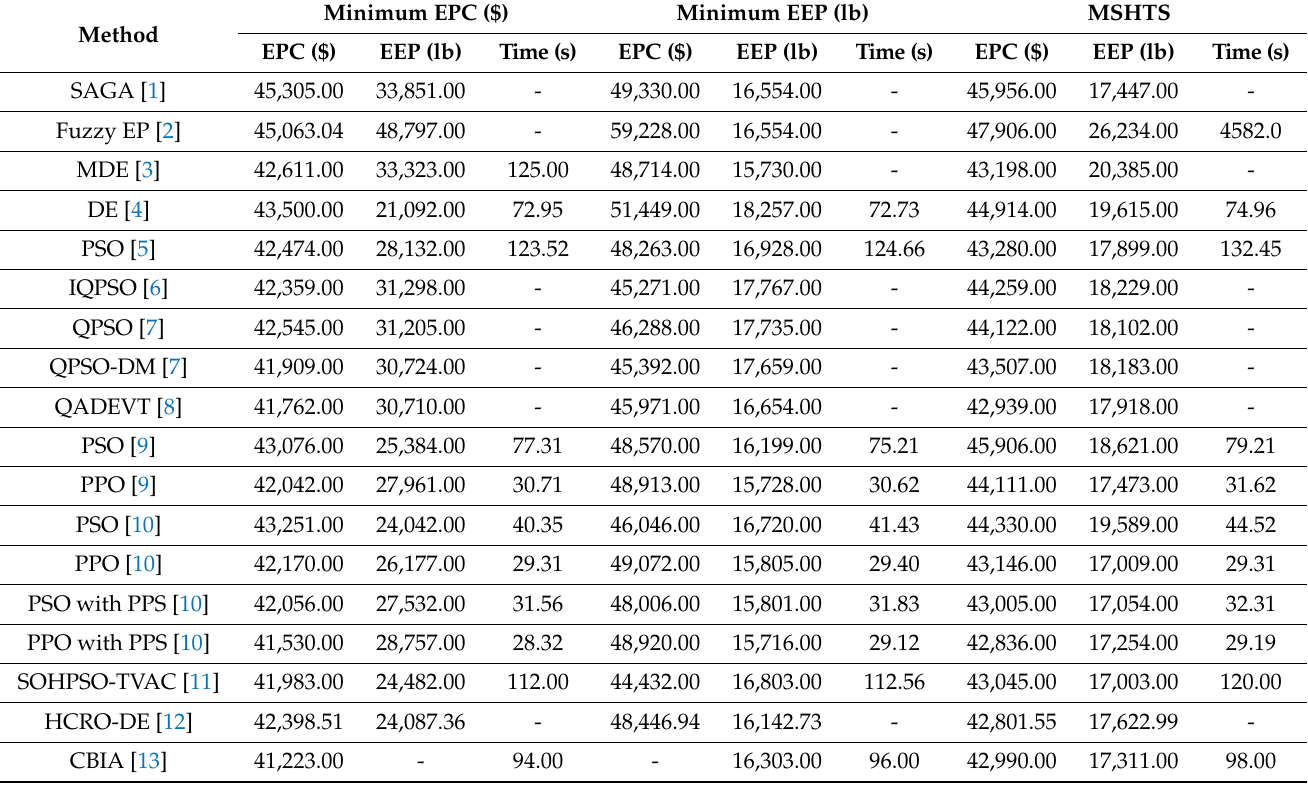
Table 1. Performance evaluation of different methods for MSHTS of Test